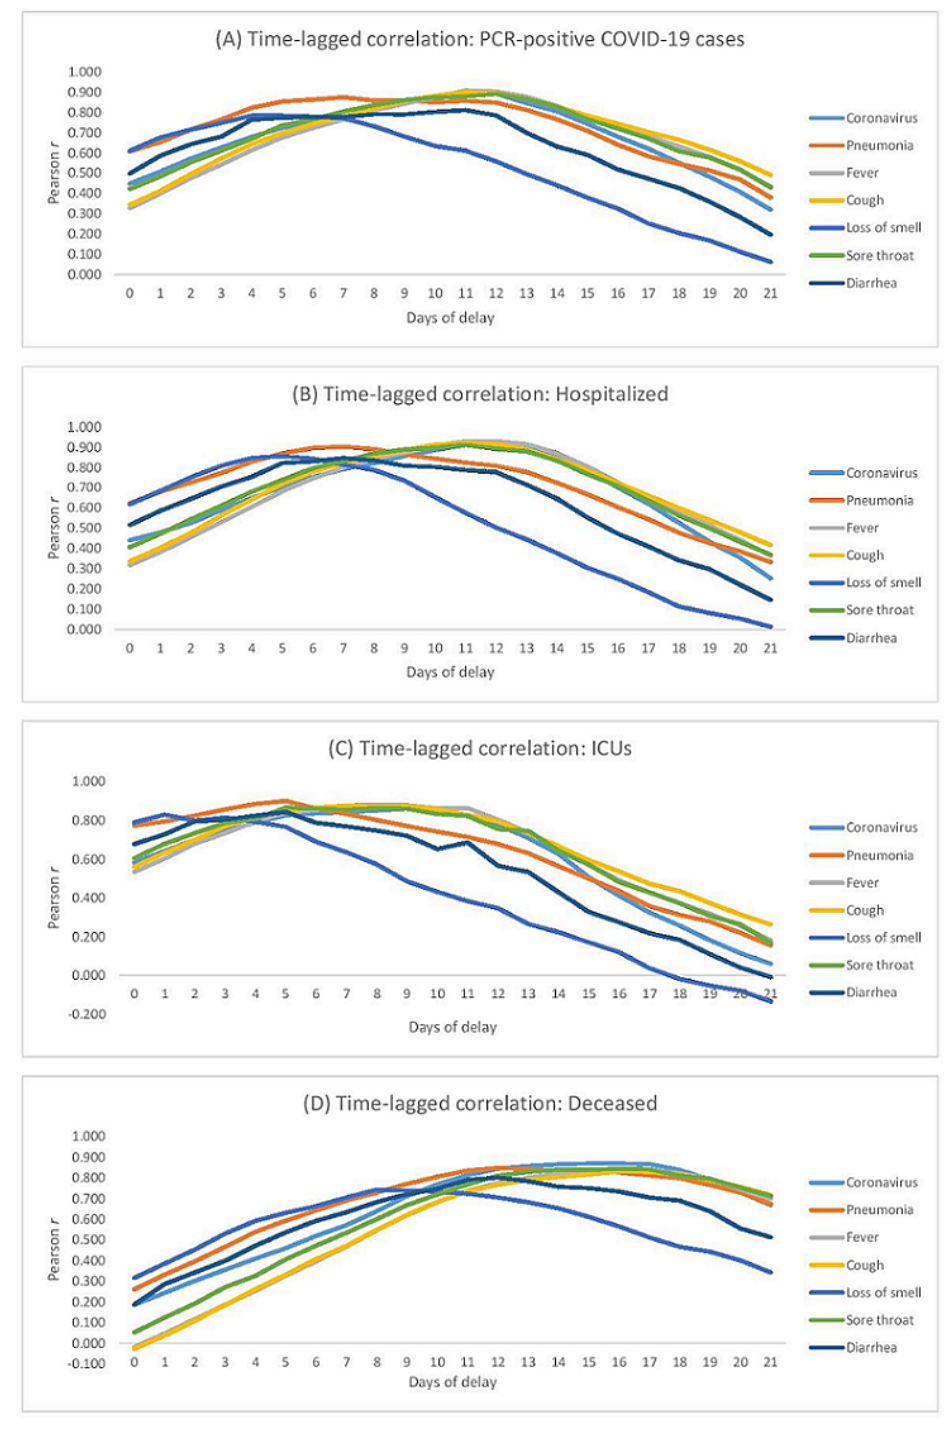
Figure 2. Graphs that show the day with the best correlation between daily PCR-positive COVID-19 cases and GT searches for COVID-19–related keywords. (A) Graph for the comparison between GT search terms and the number of PCR-positive COVID-19 cases, with different day ranges for delay. (B) Graph for the comparison between GT search terms and the number of people hospitalized due to COVID-19, with different day ranges for delay. (C) Graph for the comparison between GT search terms and the number of admissions to the ICU due to COVID-19, with different day ranges for delay. (D) Graph for the comparison between GT search terms and the number of people deceased due to COVID-19, with different day ranges